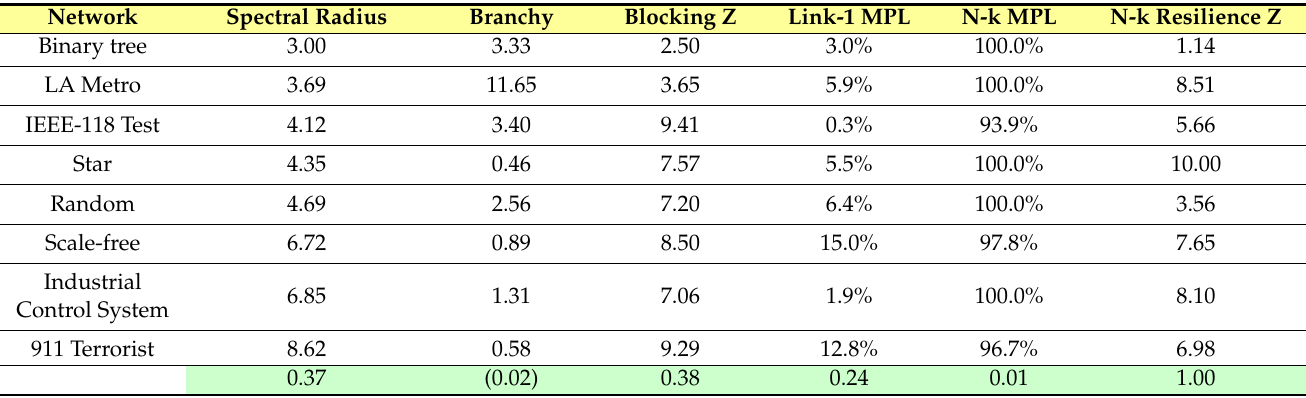
Table 2. Results for flow cascade simulations on the collection of networks. N-k Z is only mildly correlated with the properties